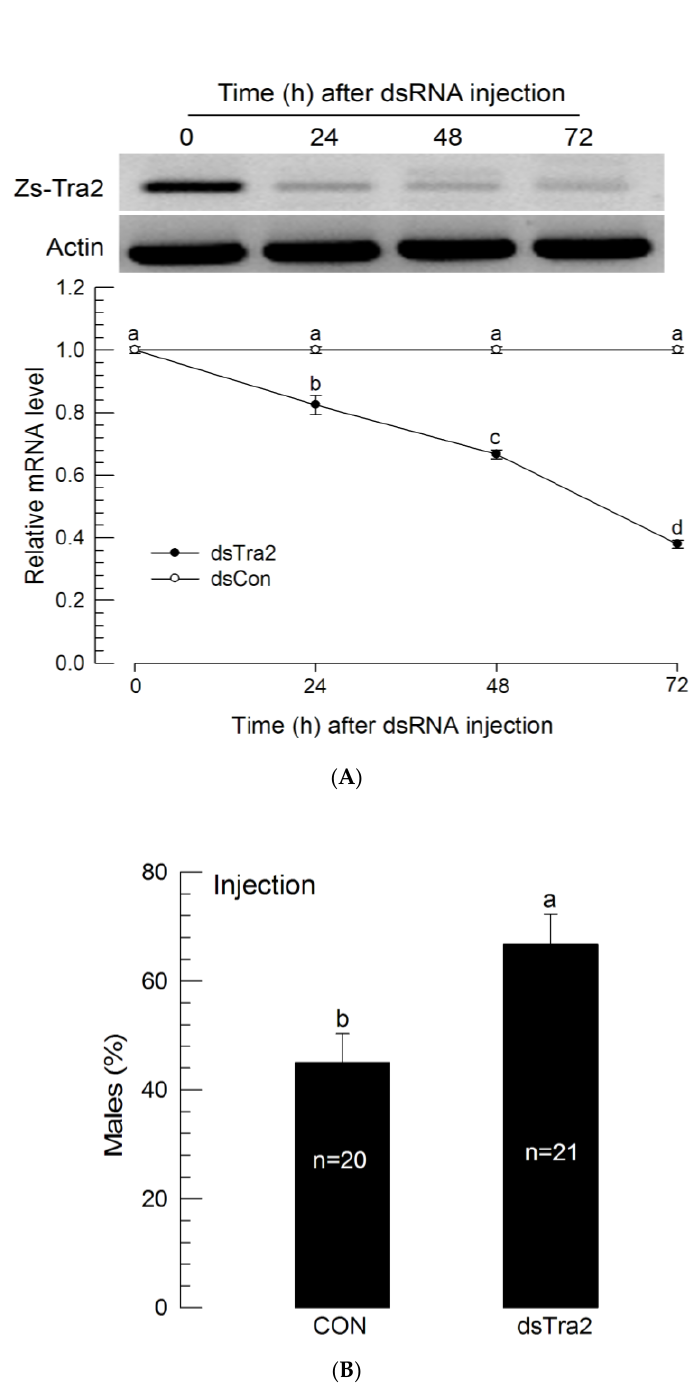
Figure 3. Influence of dsRNA (‘dsTra2’) specific to Zs-Tra2 on male-biased adult production in Z. scutellata . RNAi was performed by injecting 0.03 µ L (500 ng / µ L) of dsRNA to newly molted L1 larvae ( < 12 h) by microinjection. For dsRNA control (‘dsCon’), dsRNA specific to CpBV-ORF302 was prepared with the method of Park and Kim (2010). ( A ) RNAi efficiency was assessed by RT-qPCR. Actin was used as a reference gene of RT-qPCR to normalize target gene expression level. Each treatment was replicated with independently prepared samples. ( B ) Outcome was assessed in ratio of male adults. Number indicate the number of assessed adults. Different letters above standard deviation bars indicate significant difference among means at Type I error = 0.05 (LSD test).